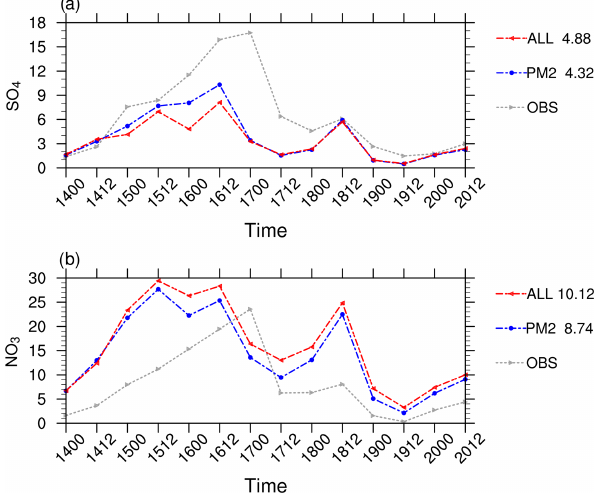
Figure 13. Time series of (a) sulfate and (b) nitrate over 14–20 Jan- uary, verified against the size-resolved particle observation at IUM station (units: µgm − 3 ). The gray, blue, and red lines denote the observation and the results of experiments PM2 and ALL, respec- tively. The numbers to the right of each panel denote the averaged RMSE over 14–20 January for different